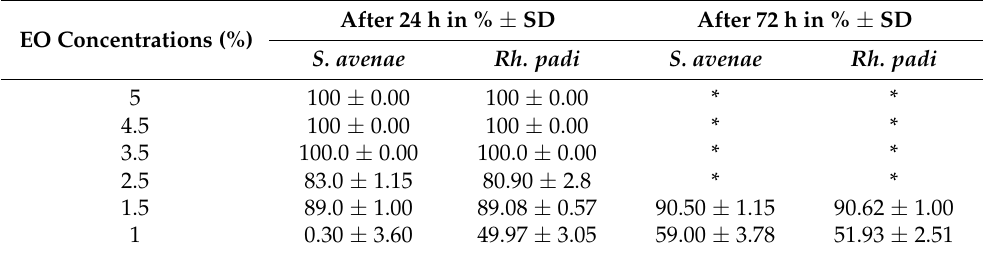
Table 6. Means of the repellent activities obtained from the concentrations of commercial EO of H. perforatum from Bulgaria (Com, Bul) against Rhopalosiphum padi and Sitobion avenae (mean ± SD). % nb/leaf S. avenae ± SD EO Concentrations (%) Treated Plant Control Treated